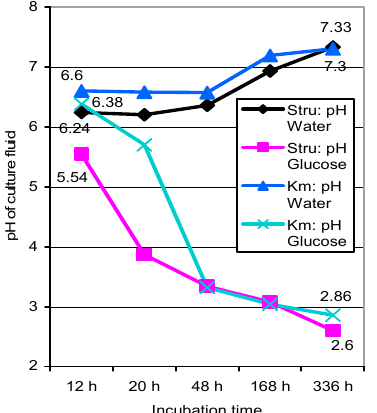
Figure 4. pH shifts in aqueous and glucose-amended 1-mL suspensions of unwashed S. rugoso-annulata and K. mutabilis basidiospores (4 g L − 1 ) incubated in cuvettes over 336 h. Values deviate < 0.1 to 0.2 pH units from those of washed basidiospores.